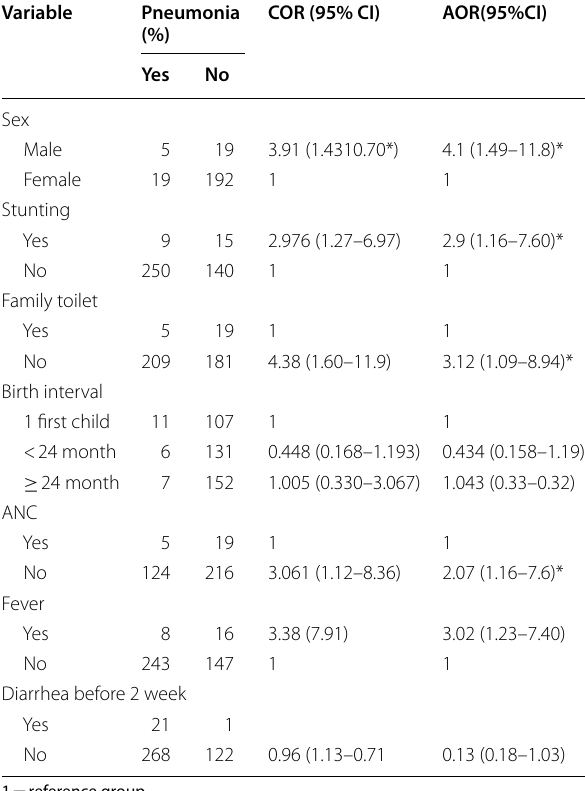
Table 4 Multivariate logistic regression analysis